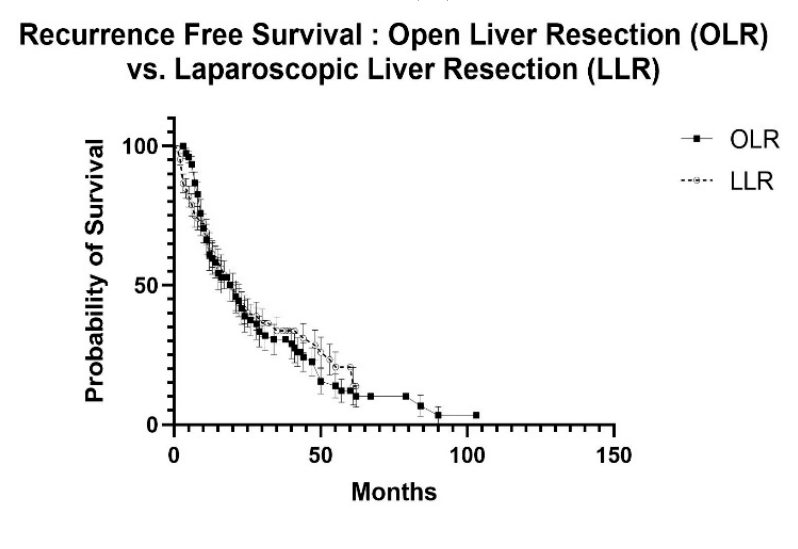
Figure 2. ( A ) Overall survival curves for open liver resection (OLR) vs. robotic liver resection (RLR) after propensity score matching (PSM) for colorectal liver metastases (CRLMs), ( B ) recur- rence-free survival curves for open liver resection (OLR) vs. robotic liver resection (RLR) after Pro- pensity Score Matching (PSM) for colorectal liver metastases (CRLMs).